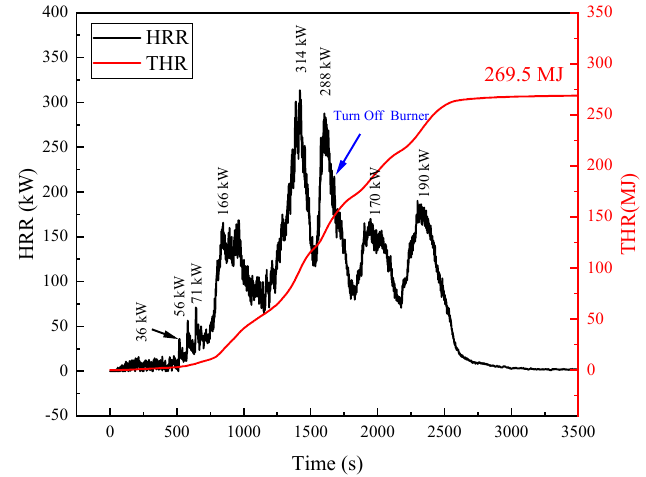
Figure 8. HRR and THR variations for LIB pack at different combustion states. The five peaks indicated five stages of LIB pack combustion and combustion pro- cesses between five different battery layers. The curve between peaks indicated stable combustion processes between separate battery layers. Figure 9 shows the LIB pack com- bustion evolution process. Figure 9. Five stages of LIB pack combustion. Stage 1 occurred after the first safety valve rupture. As the propane flame continu- ously heated the bottom and front surfaces of batteries in layer 1, the first battery TR gen- erated the first HRR peak. In stage 1, the energy that caused battery TR mainly came from propane flame and self-heating. As the intense jet fire of batteries in layer 1 turned to sta- ble combustion, the value of HRR gradually decreased and stage 1 ended. Stage 2 was the result of intense combustion of the batteries in layer 2. The batteries in layer 2 were composed of two parts. The first part was on both sides of the LIB pack, in which the heating area was much smaller than that of layer 1. Therefore, the TR times were slightly later than those in layer 1. The second part was protected by layer 1 and the propane flame heated only the bottom of the batteries. At this point, the second part was also subjected to continuous heat transfer from batteries in layer 1. Zhou et al. [12] inves- tigated the impact of heating position on battery TR and found that compared with front surface heating, bottom surface heating caused more intense exothermic reactions and a later TR time. The bottom surface heating mode led to a higher and later HRR peak than in stage 1.